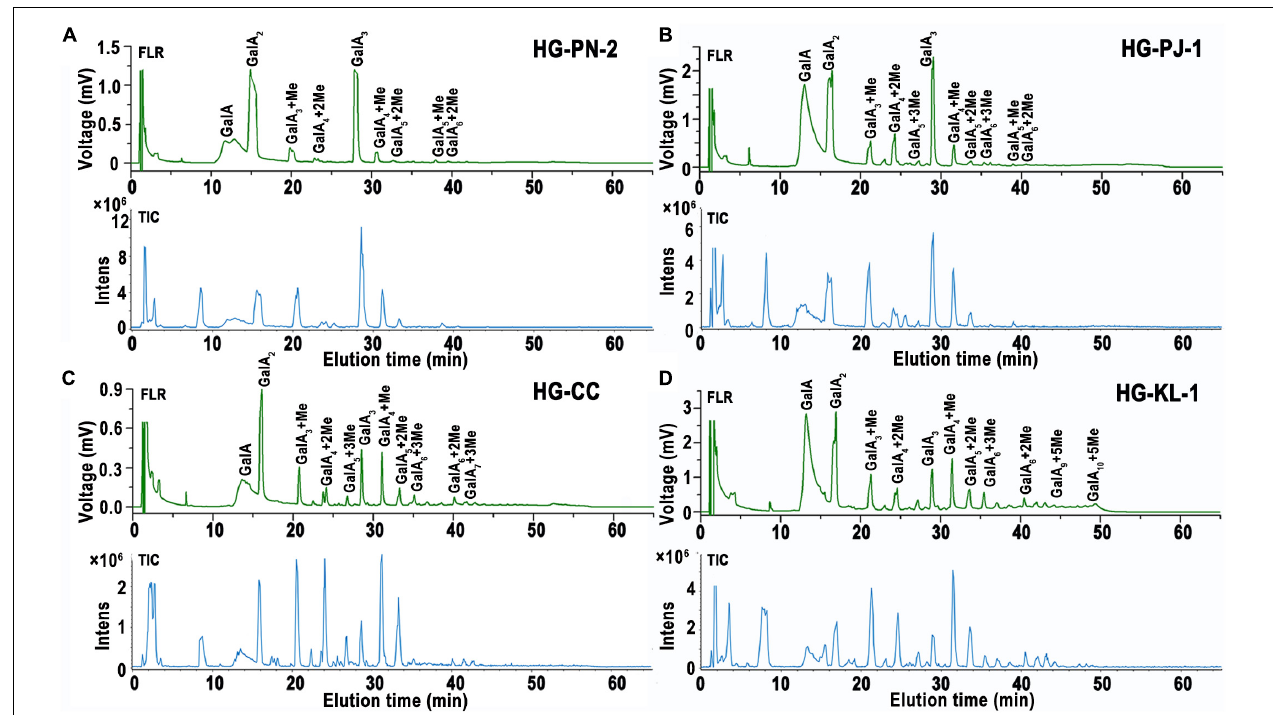
FIGURE 4 | HILIC elution patterns of GalA-oligomers produced from HG pectins with different degrees of methyl-esterification (DM). (A) HG-PN-2 (Class I); (B) HG-PJ-1 (Class II); (C) HG-CC-1 (Class III); and (D) HG-KL-1 (Class IV).